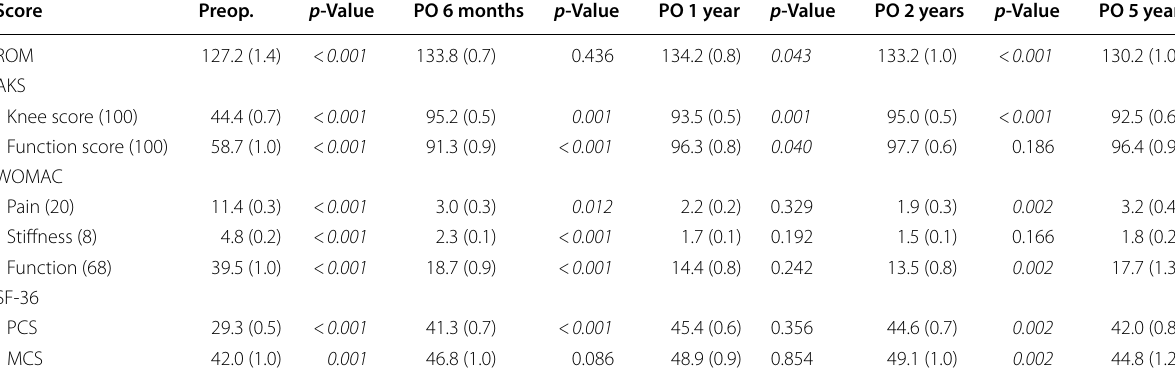
Preop. preoperative, PO postoperative, ROM range of movement, AKS American Knee Society score, WOMAC Western Ontario and McMaster Universities Arthritis Index score, SF-36 36-Item Short Form Health Survey, PCS physical component summary, MCS mental component